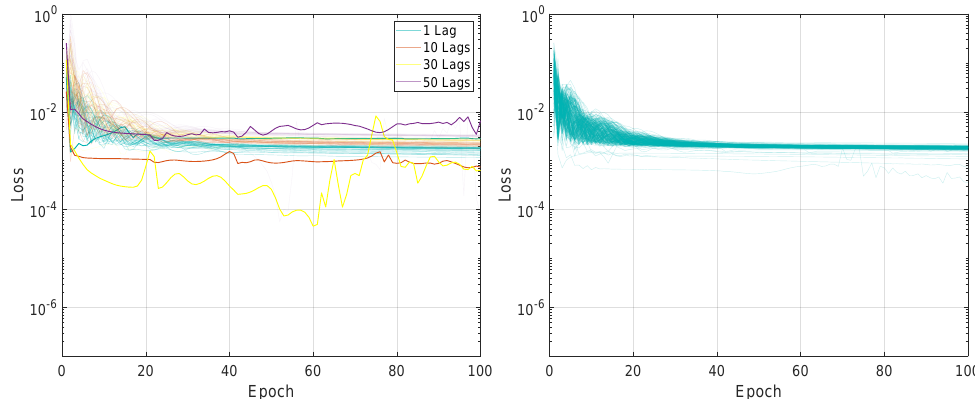
Figure 19. Illustration of the training loss for Experiment 2, LSTMTF ( left ) and VLSTM ( right ), using a many-to-one prediction mode. Compared to the MISO configuration, here, the overall testing MAE for all three neural networks, namely, LSTMTF, LSTMTF, and VLSTM, running in both prediction modes, namely, M2M and M2O, has shown a decrease for all mini-batch sizes. This can be seen in Figures 8, 9, 20 and 21.